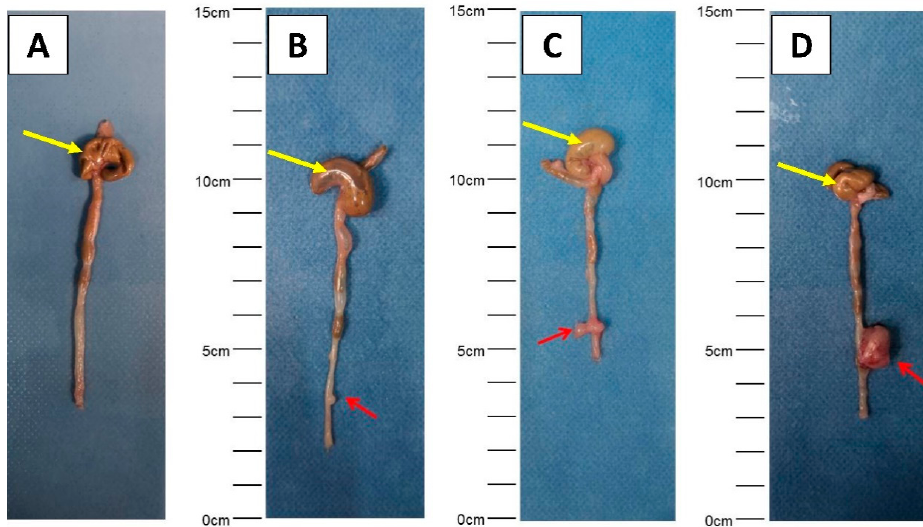
Figure 2. Representative images showing various sizes of primary tumor detected during gross examination (( A ) negative control, ( B – D ) different sizes of primary tumors). Primary tumors are indicated by red arrows (cecum: yellow arrows). Table 1. Outcomes after endoscopy-guided injection of CT26 cells into BALB/C mice: mortality within the observation period, tumor take rate, tumor volume, and the rates of distant metastasis in experimental groups with varying number of cells injected or observation periods.